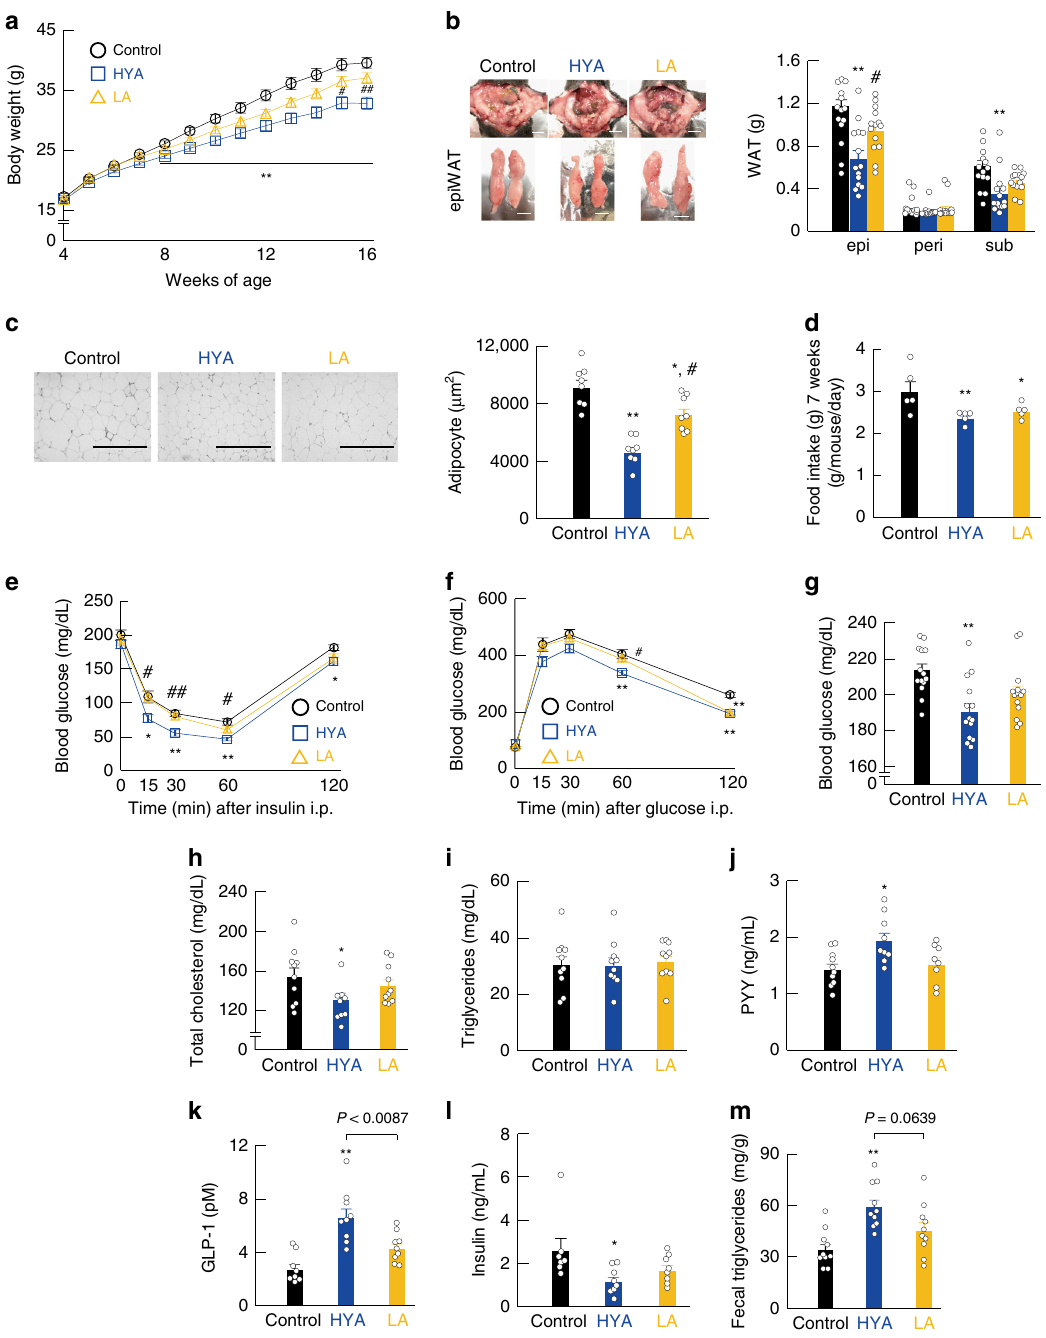
Fig. 3 Gut microbial PUFA metabolites improve host metabolic conditions. Changes in a body weight and b representative macroscopic appearance and tissue weights ( n = 14 per group). Scale bar; 1 cm. epi, epididymal; peri, perirenal; sub, subcutaneous. c Hematoxylin – eosin (H&E) – stained WAT and the mean area of adipocytes ( n = 8 per group). Scale bar, 400 μ m. d Daily food intake measured at 7 weeks of age ( n = 5 per group). e ITT ( n = 10 per group) and f GTT ( n = 10 per group) were analyzed at 13 – 14 weeks of age. g Blood glucose ( n = 14 per group), h total plasma cholesterol ( n = 10, 9, and 10 per group), i triglyceride ( n = 10 per group), j PYY ( n = 10, 9, and 8 per group), k GLP-1 ( n = 8, 9, and 9 per group), and l insulin ( n = 7, 8, and 8 per group) levels were measured at the end of the experimental period. m Fecal triglyceride levels were measured at 16 weeks of age ( n = 10 per group). ** P < 0.01; * P < 0.05 vs. control (Tukey – Kramer test). ## P < 0.01; # P < 0.05 vs. HYA (Tukey – Kramer test). Results are presented as means± SE. Source data